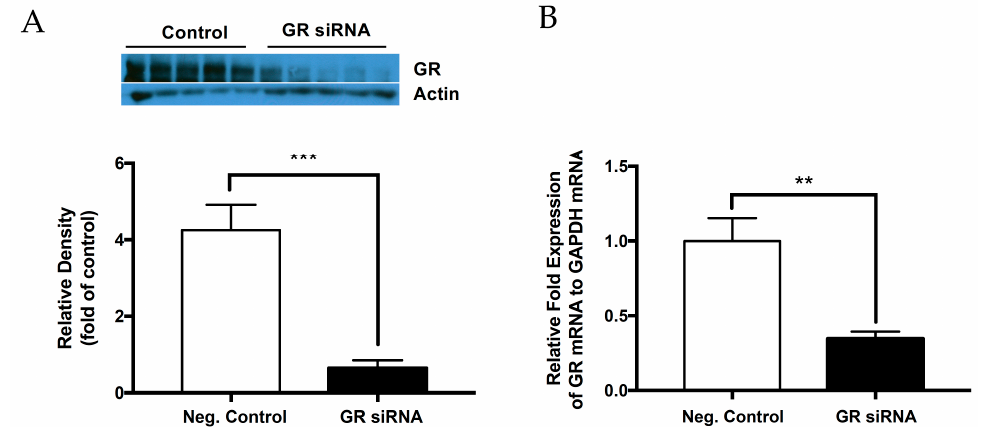
Figure 1. Glucocorticoid receptor is effectively knocked down at the protein and mRNA level. The glucocorticoid receptor (GR) siRNA repressed GR expression in the neonatal rat brain. The neonatal rats received either GR siRNA (100 pmol) or negative control (100 pmol) via intracerebroventricular (ICV) injection seven days after birth (P7). The brain samples were collected 48 hours after ICV treatment and glucocorticoid receptor (GR) protein abundance was evaluated via Western blotting ( A ) and mRNA abundance was evaluated ( B ) via real-time RT-qPCR relative to GADPH, respectively. Data are means ± SEM. n = 5. ** p < 0.01 *** p < 0.001, GR siRNA vs. negative control.